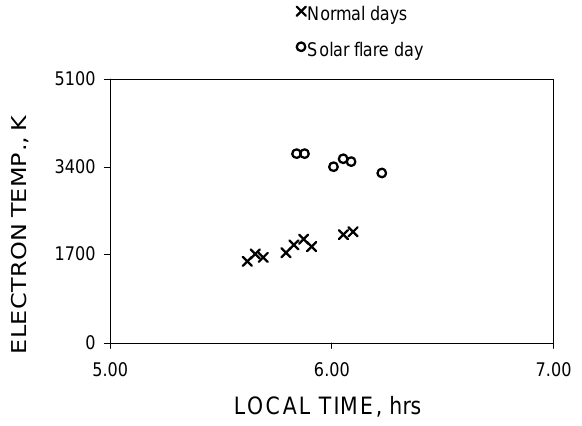
Fig. 1. Variation of electron temperature recorded by the SROSS- C2 satellite during solar flares and normal days at Bhopal.